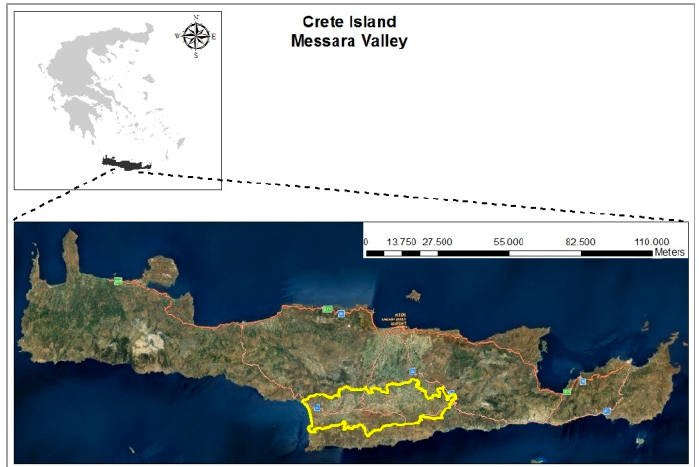
Figure 1. Location of the Messara valley.